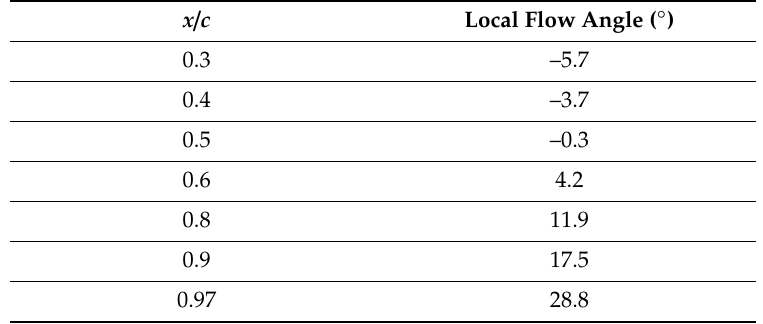
Figure 13. Pressure coefficient contour and streamwise locations. Table 3. Streamwise locations and local flow angles. Table 3. Streamwise locations and local flow angles.